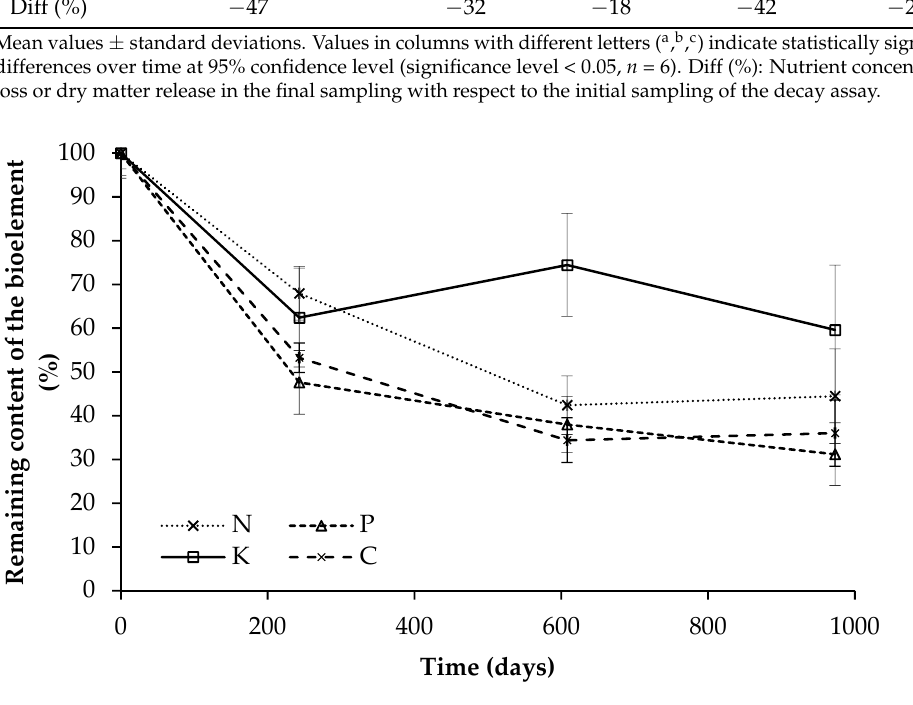
Figure 3. Remaining C, N, P, and K in decomposing leaf litter over time.